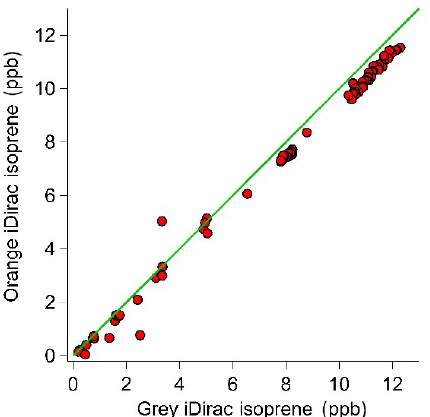
Figure 10. Scatter plot with the 1 : 1 line showing the 15min aver- age values for the grey and orange iDirac instruments.